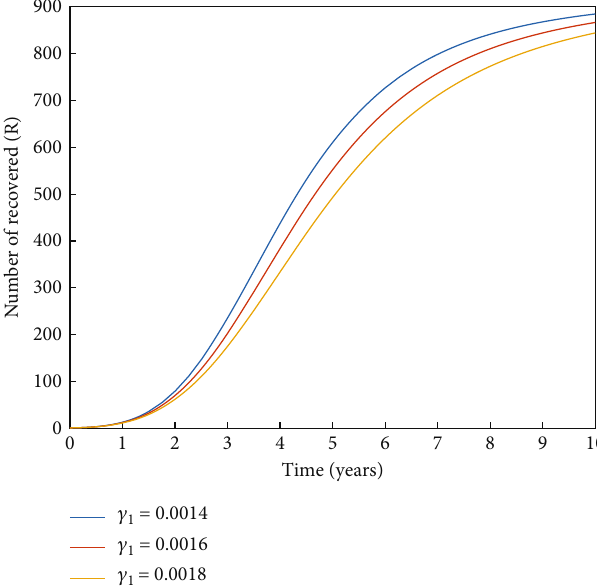
Figure 22: Transformation of recovered individuals for recovery rate ψ 1 with various values.